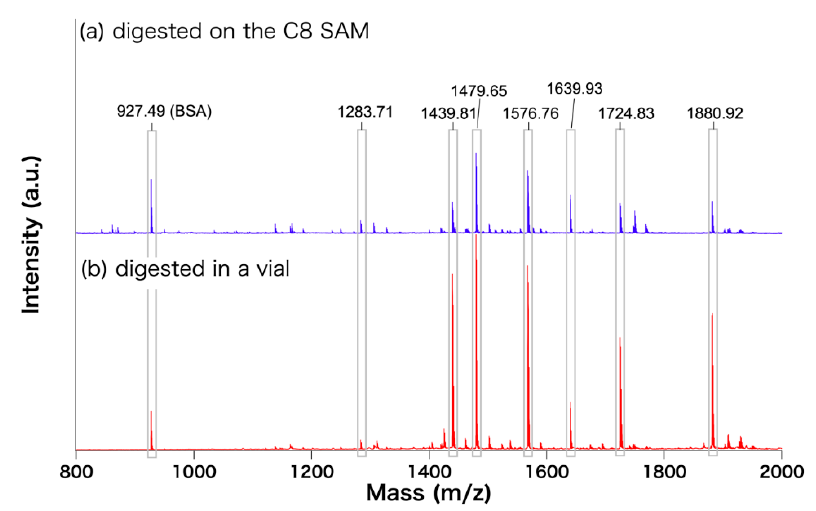
Figure 4. MALDI-ToF mass spectra of digested BSA. ( a ) BSA adsorbed on the C8 SAM then digested